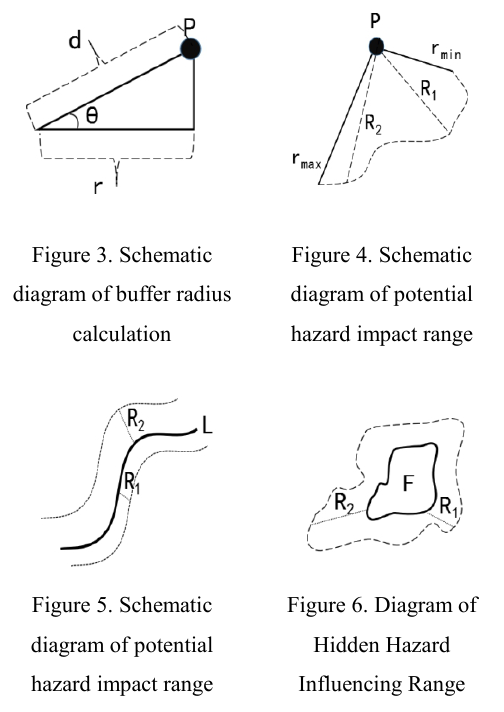
Figure 5. Schematic diagram of potential hazard impact range